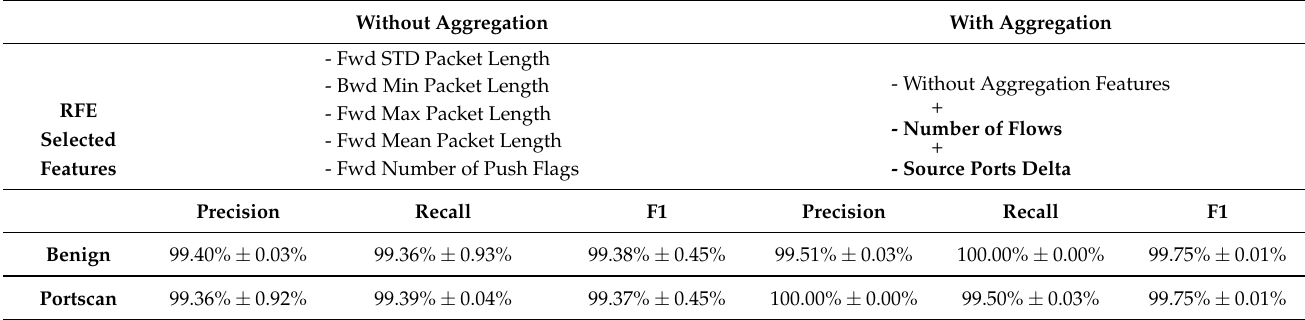
Table 7. Benign vs. PortScan classification (5-fold cross